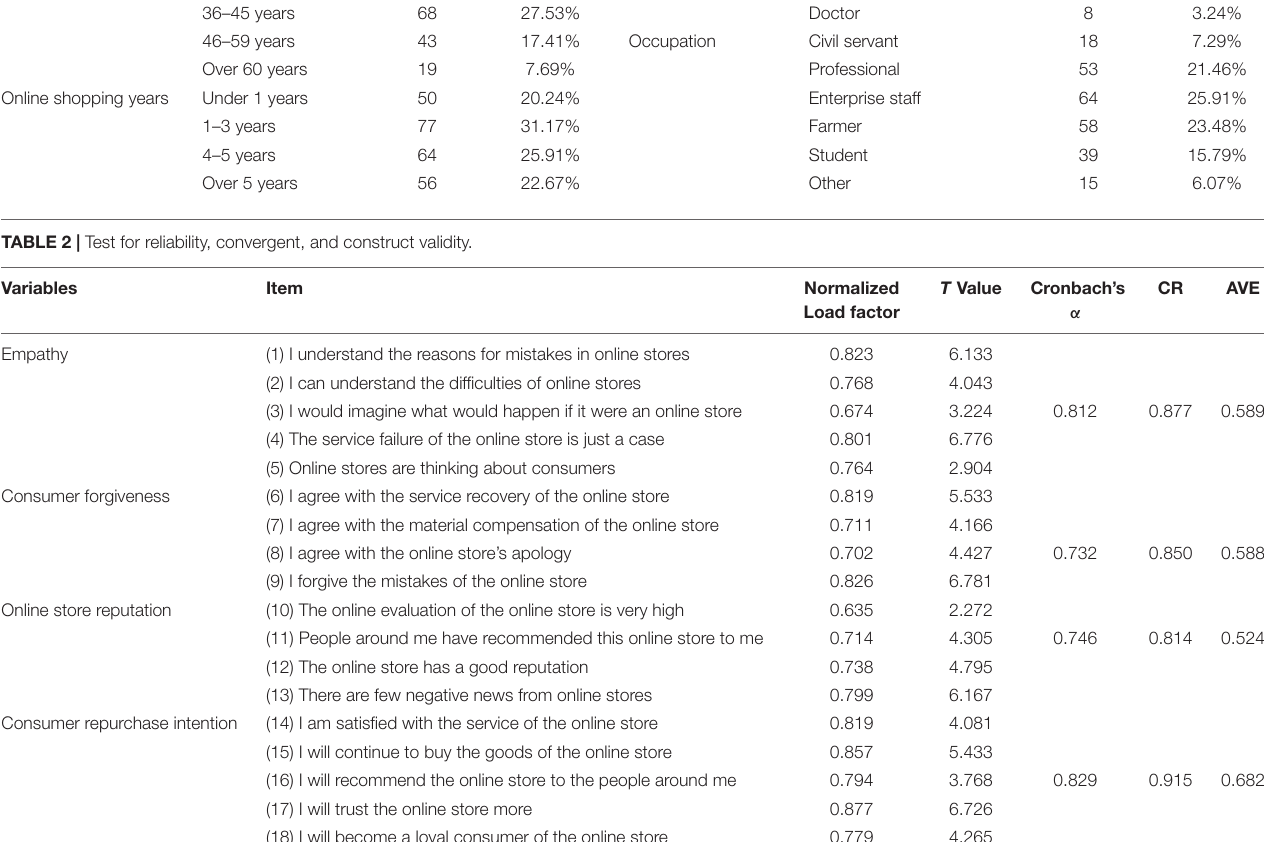
TABLE 1 | Sample statistics.